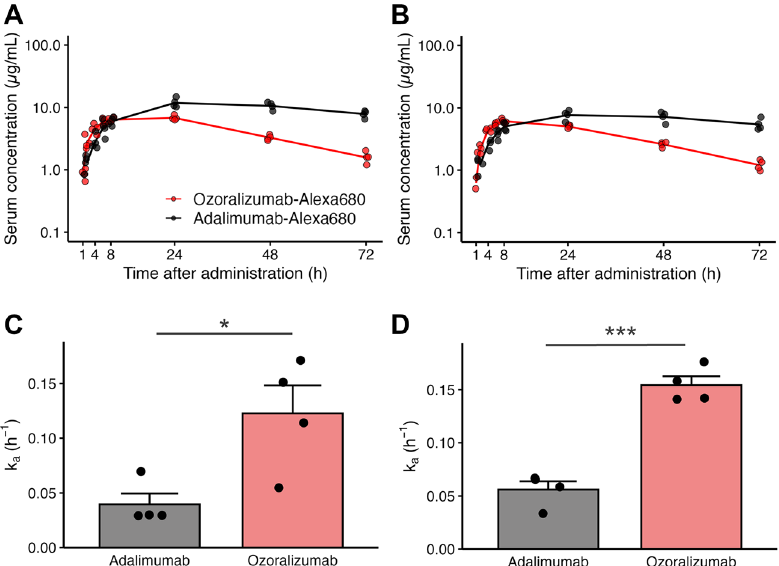
Figure 6. Serum concentration–time profiles of ozoralizumab-Alexa 680 and adalimumab-Alexa 680 after a single subcutaneous injection. At 1, 2, 4, 6, 8, 24, 48, and 72 h after subcutaneous injection of 2 mg/kg of ozoralizumab-Alexa 680 or 2 mg/kg of adalimumab-Alexa 680, the antibody concentrations in the serum were investigated in naive mice ( A ) and CIA model mice ( B ). Dot plots represent each individual data, and the lines represent the mean; red, ozoralizumab-Alexa 680; black, adalimumab-Alexa 680; n = 4 mice per group. The absorption rate constant